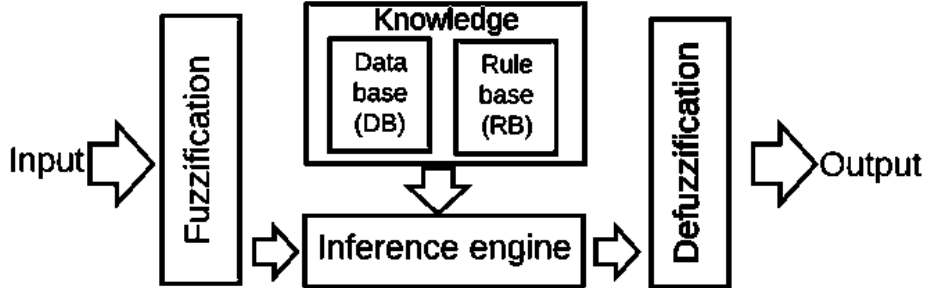
Figure 1. Mamdani-type fuzzy model components. Source: Reference